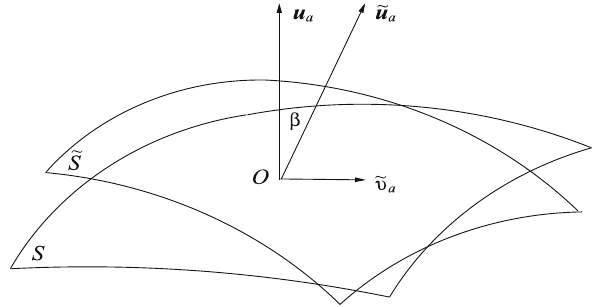
Fig. 1 Observer ( O ) moving with peculiar velocity ˜ v a (where ˜ v 2 (cid:2) 1 in our case), relative to the Hubble flow. The 4-velocities u a and ˜ u β between them, respectively define a , with a hyperbolic (tilt) angle the reference frame of the smooth universal expansion and that of the peculiarmotion(seeEq.(1)).The3-Dhypersurfaces S and ˜ S arenormal to u a and ˜ u a and they respectively define the rest-spaces of the idealised observers and of their real